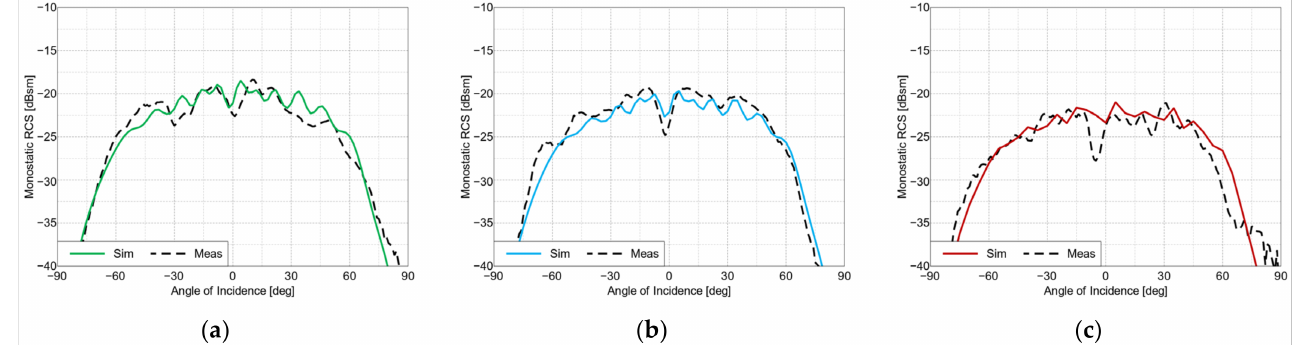
Figure 12. RCS values of the cross-polarized arrays, at frequencies of: ( a ) 57 GHz, ( b ) 62 GHz and ( c ) 67